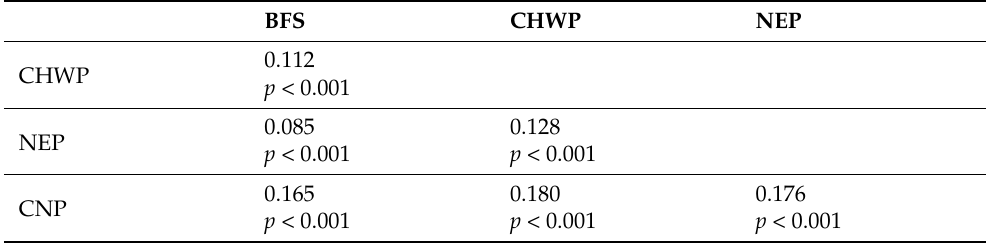
Table 3. Pairwise F ST values among four sites and p -values based on 9999